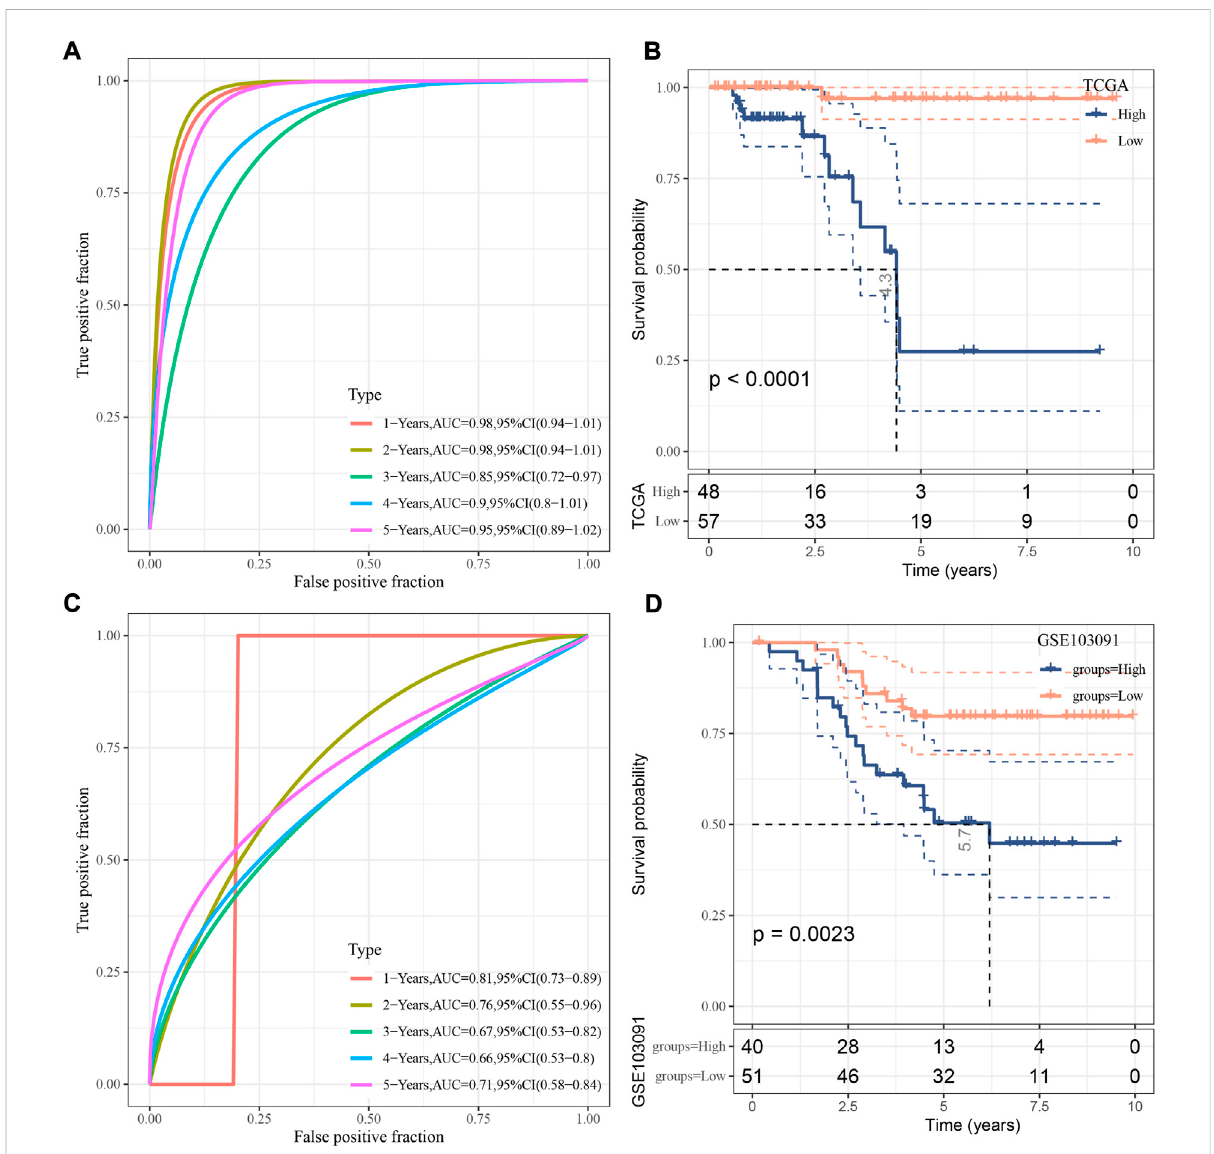
FIGURE 4 Veri fi cation of the risk model. (A) ROC analysis of the risk model in TCGA dataset. (B) Kaplan-Meier survival curve of two risk groups in TCGA dataset. (C) ROC analysisof the riskmodel inGSE103091 dataset. (D) Kaplan-Meier survival curve of two risk groups inGSE103091 dataset. Log-rank test was